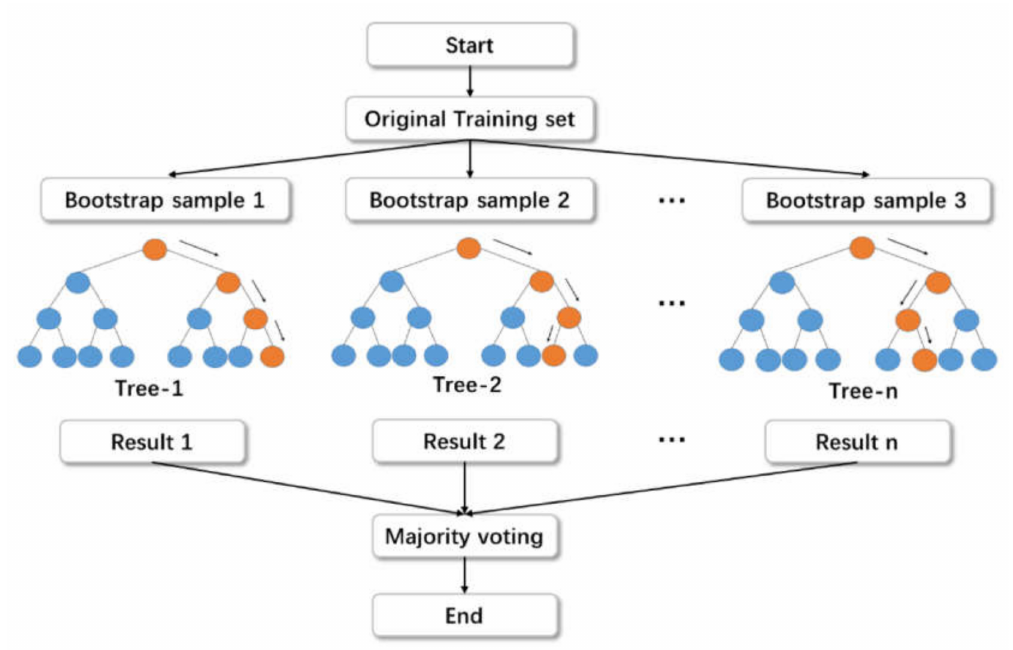
Figure 3. Random forest algorithm structure